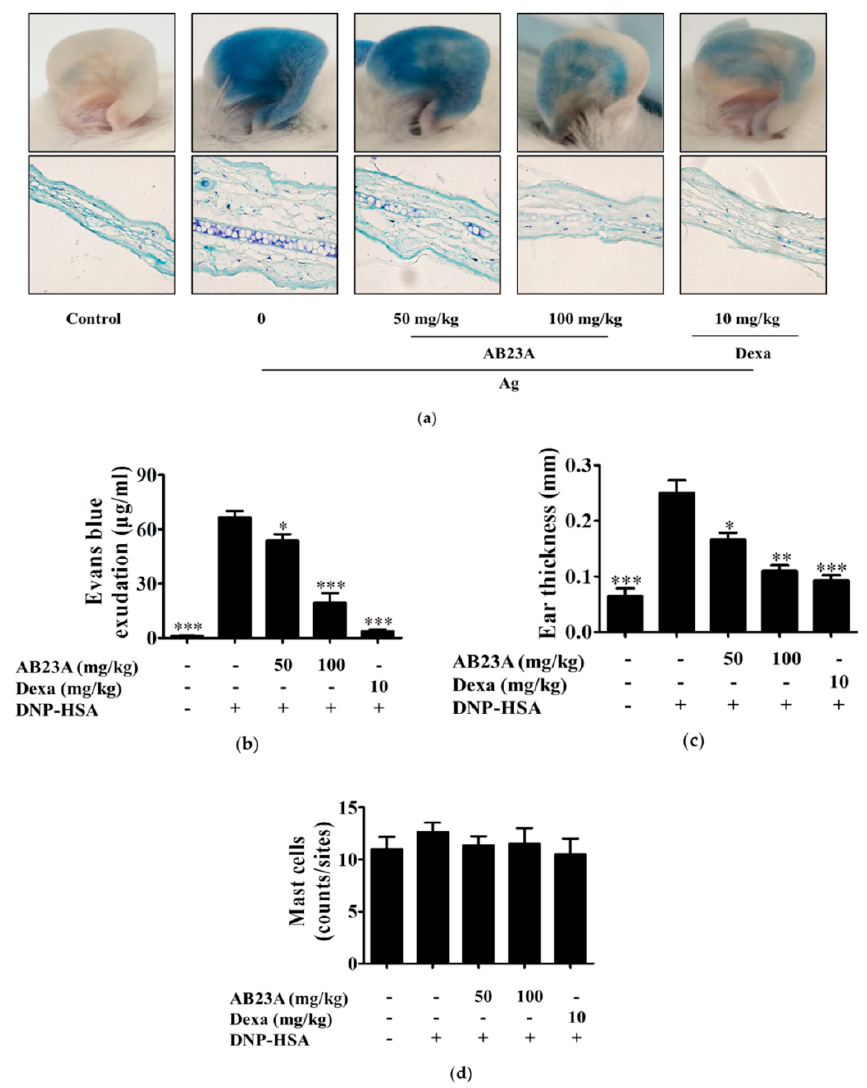
Figure 6. AB23A suppresses the IgE-mediated passive cutaneous anaphylaxis (PCA) reaction in mice. Institute of cancer research (ICR) mice were intradermally injected into both ears with 80 ng of anti-DNP IgE. After 24 h, AB23A or Dexa were orally treated 1 h before 60 µ g of DNP-HSA containing 1% Evans blue was intravenously injected into the tails of the mice. ( a ) The representative images of ears and photomicrographs of ear sections were stained with toluidine blue as shown. ( b ) The dye extracted from the ear was detected using a spectrophotometer. ( c ) Ear thickness was measured. ( d ) The number of mast cells were counted at the dermis. The data show the mean ± SEM ( n = 5 per group). ANOVA, p < 0.0001, post hoc * p < 0.05, ** p < 0.01 and *** p < 0.001, compared with the mice sensitized with anti-DNP IgE and challenged with DNP-HSA in the absence of AB23A.